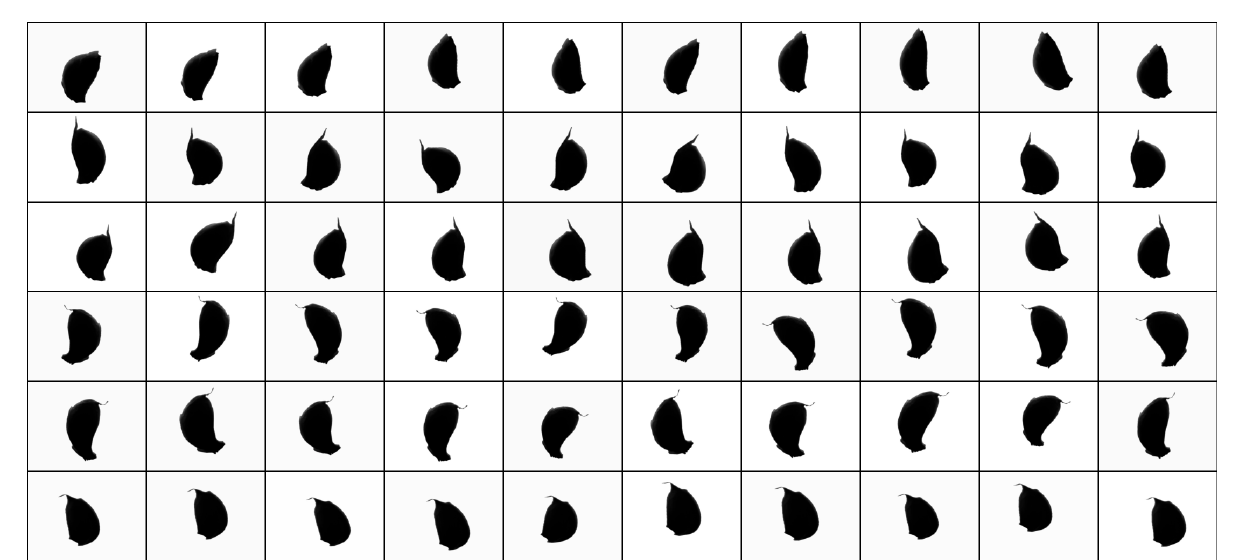
Figure 8. Samples of each orientation class. Motion Blur and Contour Extraction Seeding speed is an important performance index of garlic seeders. In order to achieve high-speed seeding, garlic seed images should be collected in motion, which may lead to motion blur in the collected images. Because of the influence of uncertain motion